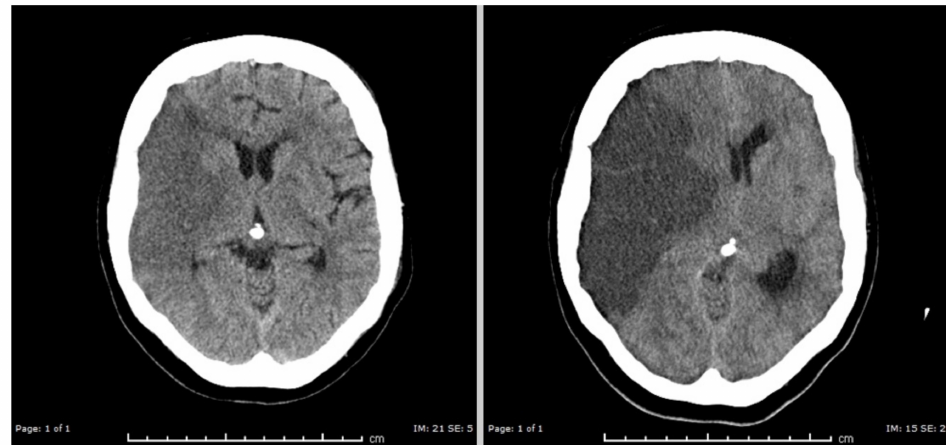
Figure 6. Cerebral edema resulting from an ischemic stroke. Left: head CT with hypodense gray and white matter on the right side of the brain (left in the picture). This essentially reflects cytotoxic cell swelling in the acute phase of the infarction. Right: head CT two days later showing massive cerebral edema of the infarcted tissue, with displacement of brain tissue to the left side. Courtesy of M. Hazewinkel, radiologist Medisch Spectrum Twente. “Reused with permission of Springer, (c) MJAM van Putten